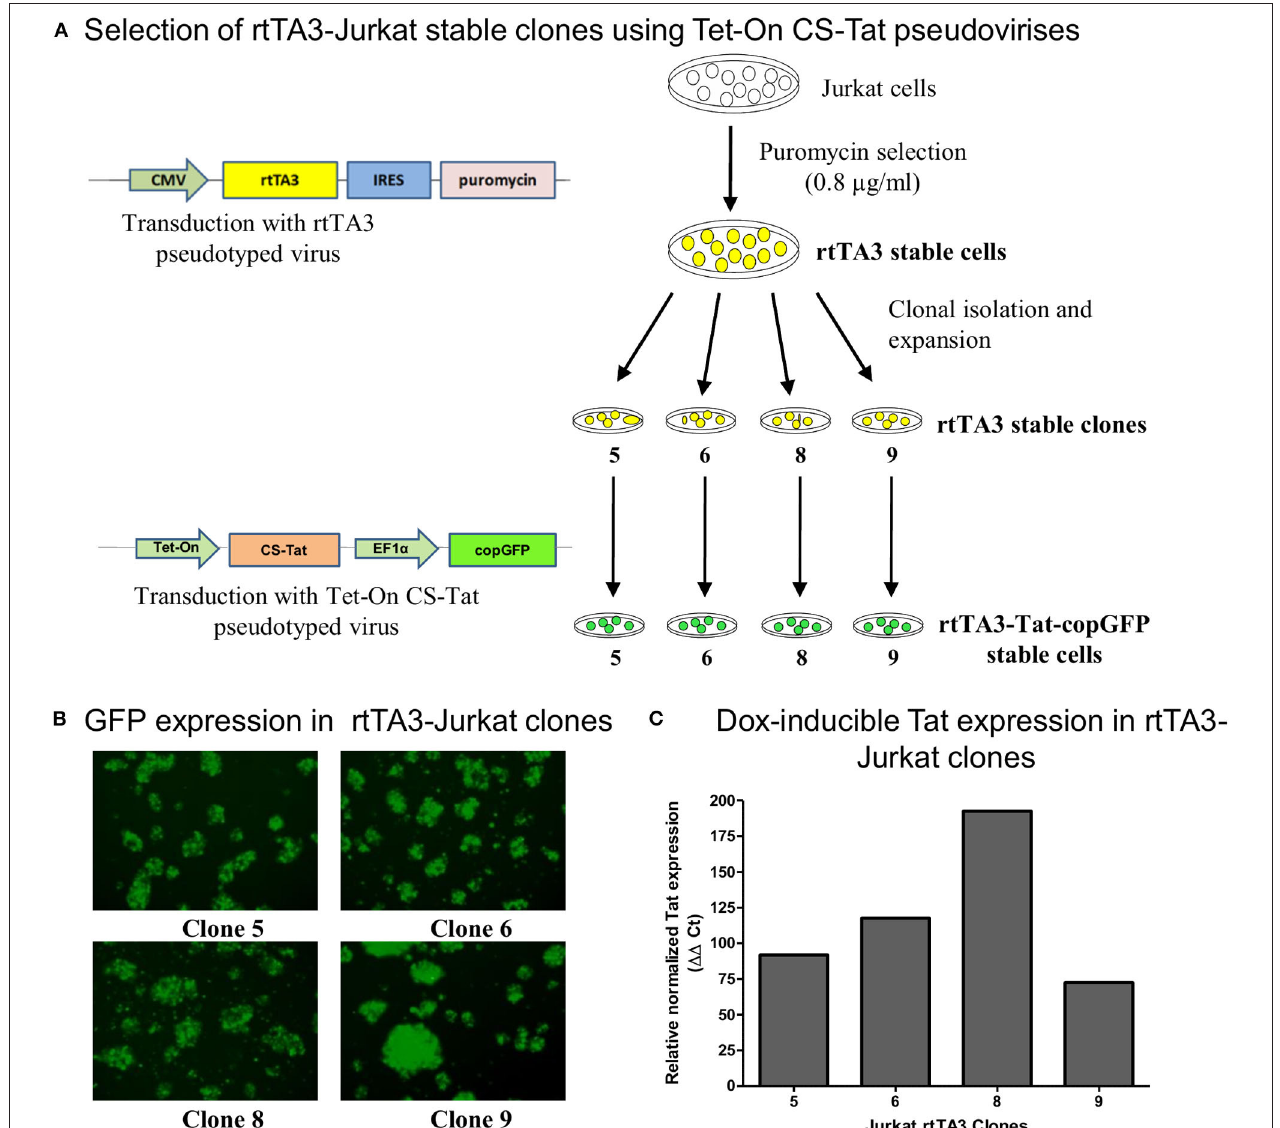
FIGURE 1 | Generation and screening of rtTA3 stable cell lines. The Tat stable cells were obtained in two successive steps. (A) First, the Jurkat cells were transduced with the CMV-rtTA3-IRES-puromycin-pseudotyped lentivirus, and a pool of stable cells was obtained by selection with puromycin. The rtTA3-puro stable cells were subsequently subjected to limit dilution to obtain clonal cell lines, and each clone was infected with 30ng/ml (p24 equivalent) of Tet-On CS-Tat EF1 α -copGFP-pseudotyped virus. (B) The cells were imaged for copGFP expression at 72h post-infection. (C) Each clonal population was subsequently treated with 800ng/ml of Dox. A “No-Dox” control for each was used to evaluate the fold increase in Tat gene expression of each clone following doxycycline treatment. The cells were harvested at 24h following Dox treatment, cDNA was synthesized from total cellular RNA, and a real-time PCR assay was performed to quantitate Tat transcripts. GAPDH was used as a reference gene control for normalization. The relative normalized Tat expression (using 11 Ct method) was